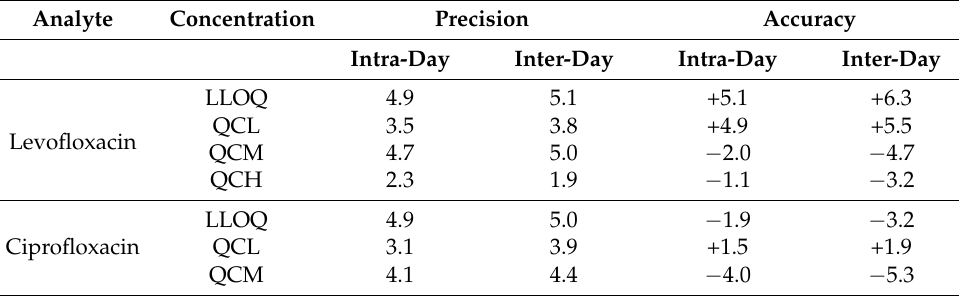
Table 1. Precision and accuracy of the proposed SPE-UHPLC-PDA method. Analyte Concentration